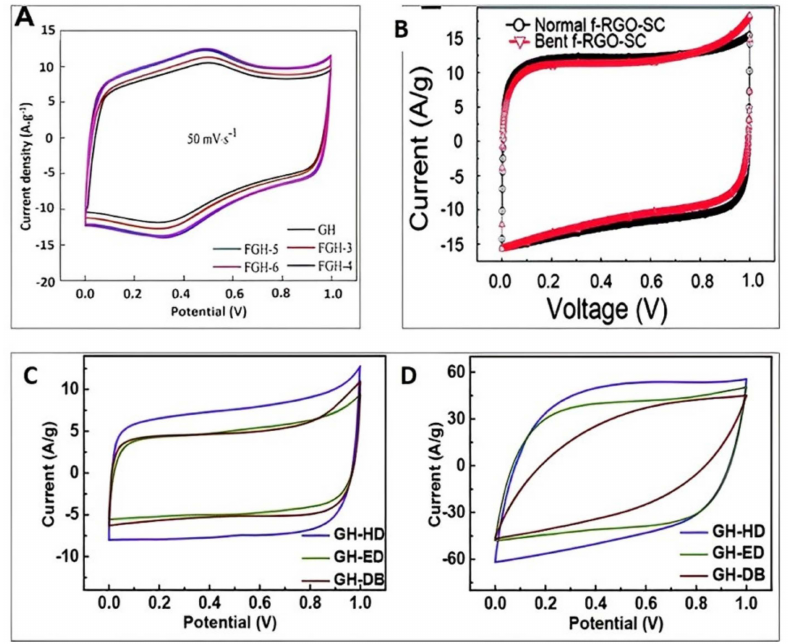
Figure 5. Electrochemical performance of supercapacitors based on graphene hydrogels. ( A ) charge- discharge characteristics of graphene-based electrode at a current density of 1 Ag − 1 and scan rate